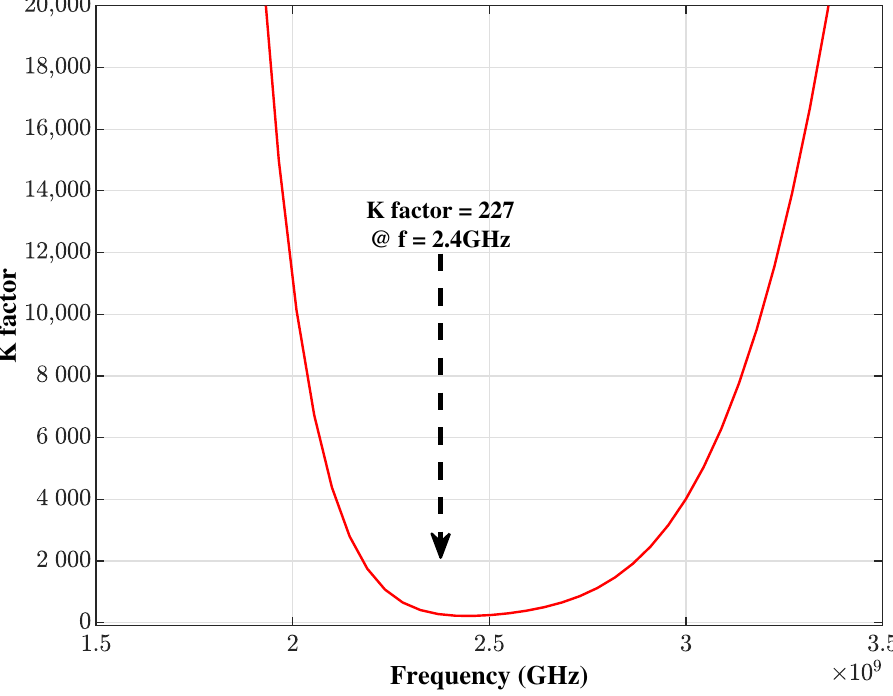
Figure 7. K factor vs. frequency for Stability